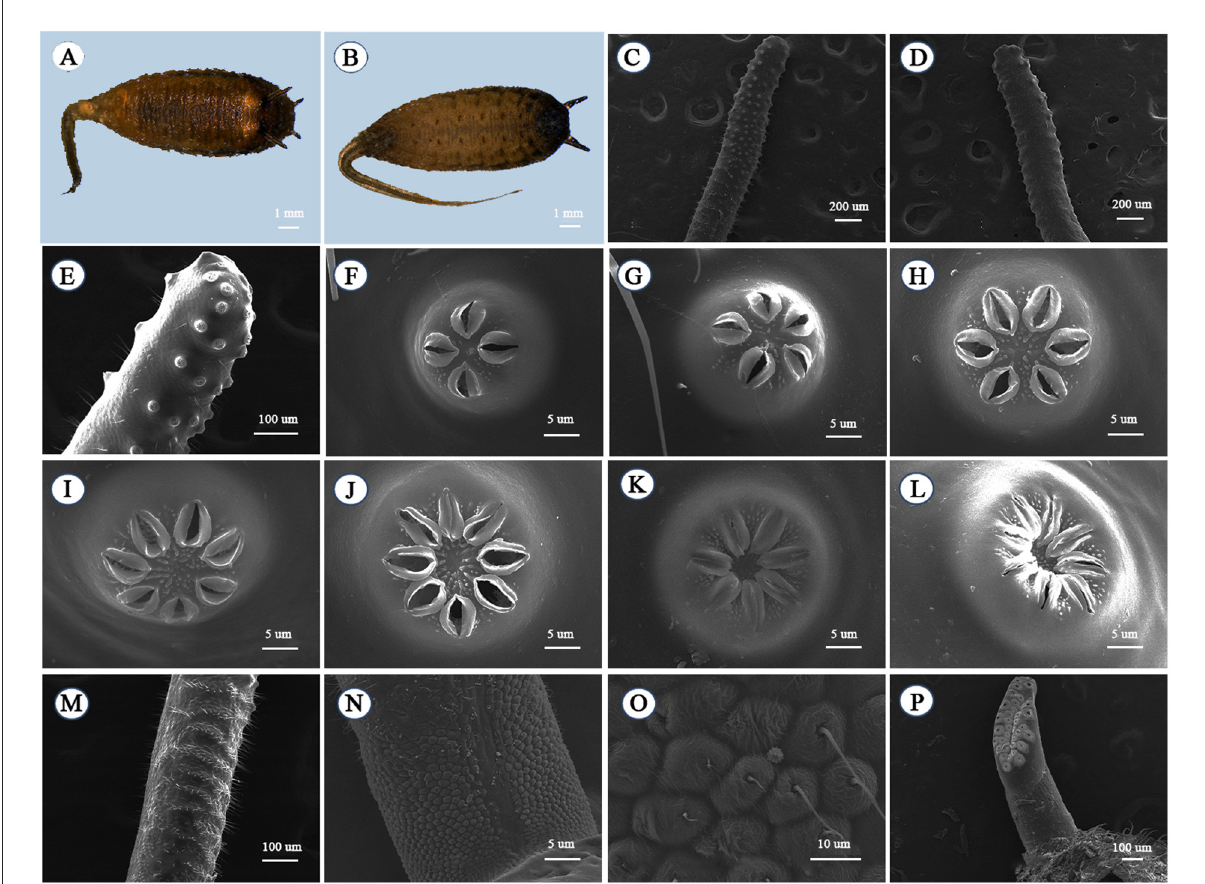
FIGURE4 Pupa of Eristalinus arvorum : (A) dorsal view and (B) pupa ventral view; pupal spiracle: (C) frontal view, (D) back view, and (E) partial frontal view; spiracular openings: (F) four-opening, (G) five-opening, (H) six-opening, (I) seven-opening, (J) eight-opening, (K) seven closed-mouth, and (L) eight closed-mouth; (M) pupal spiracle projection base; (N) ornamentation on basal part; (O) ornamentation on basal part; and (P) anterior spiracle.